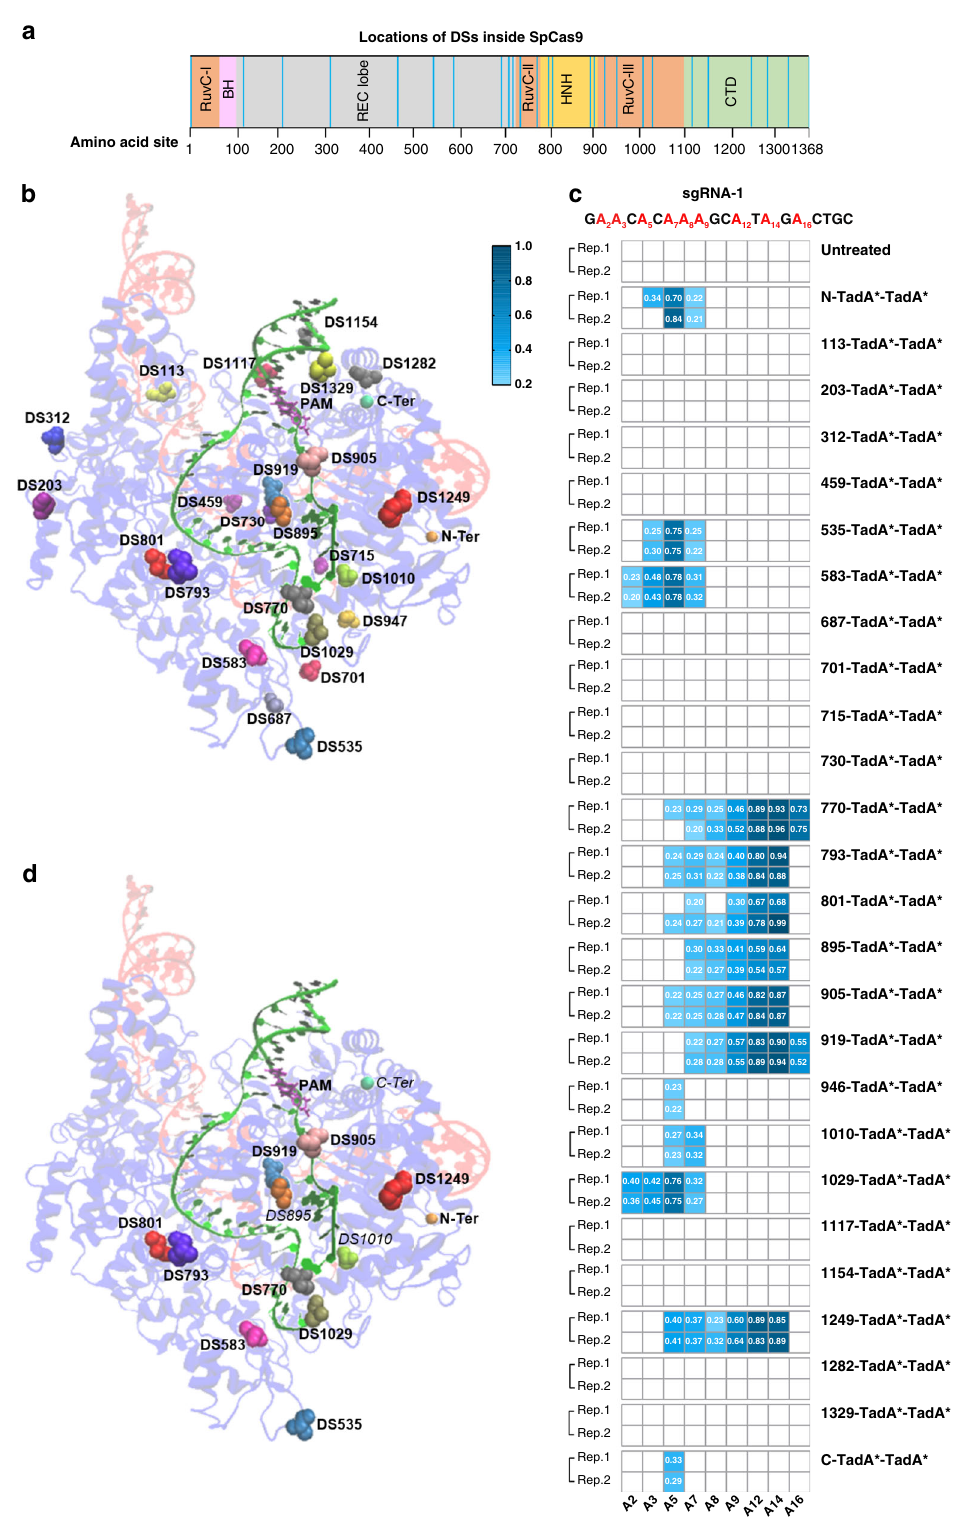
Fig. 1 Screening for functional ABE (TadA*-TadA*)-nSpCas9-DS variants. a Diagram showing SpCas9 domain organization and 24 DSs (light blue lines) screened in this study. b Locations of 24 DSs and N-/C-termini in the structure of SpCas9:sgRNA:DNA complex (PDB:5F9R). c Base editing activities of ABE (TadA*-TadA*)-nSpCas9-DS variants against sgRNA-1. Adenines in sgRNA-1 were labeled as red. A – G conversion frequencies at every adenine nucleotide in 20 bp protospacer were quanti fi ed with EditR and shown in heat map. Two independent experiments were performed and editing frequencies >0.20 were labeled in the heat map. d Locations of active DSs for ABE variants and N-/C-termini in the structure of SpCas9:sgRNA:DNA complex (PDB:5F9R). DS895, DS1010 and C-Ter were shown in italic type because of lower activities of derived ABE variants as compared to other DSs. Source data are available in the Source data fi